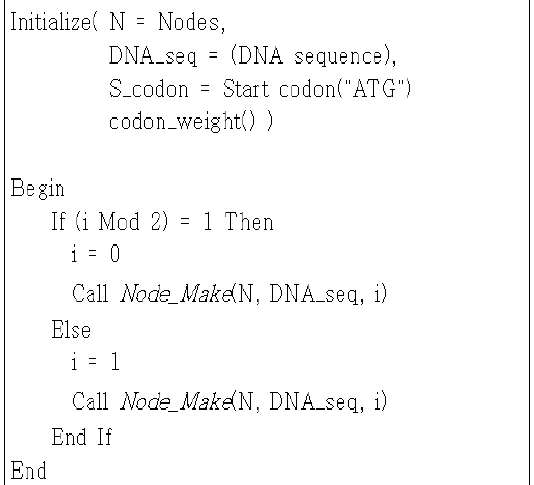
Figure 2. Procedure to express vertexes and